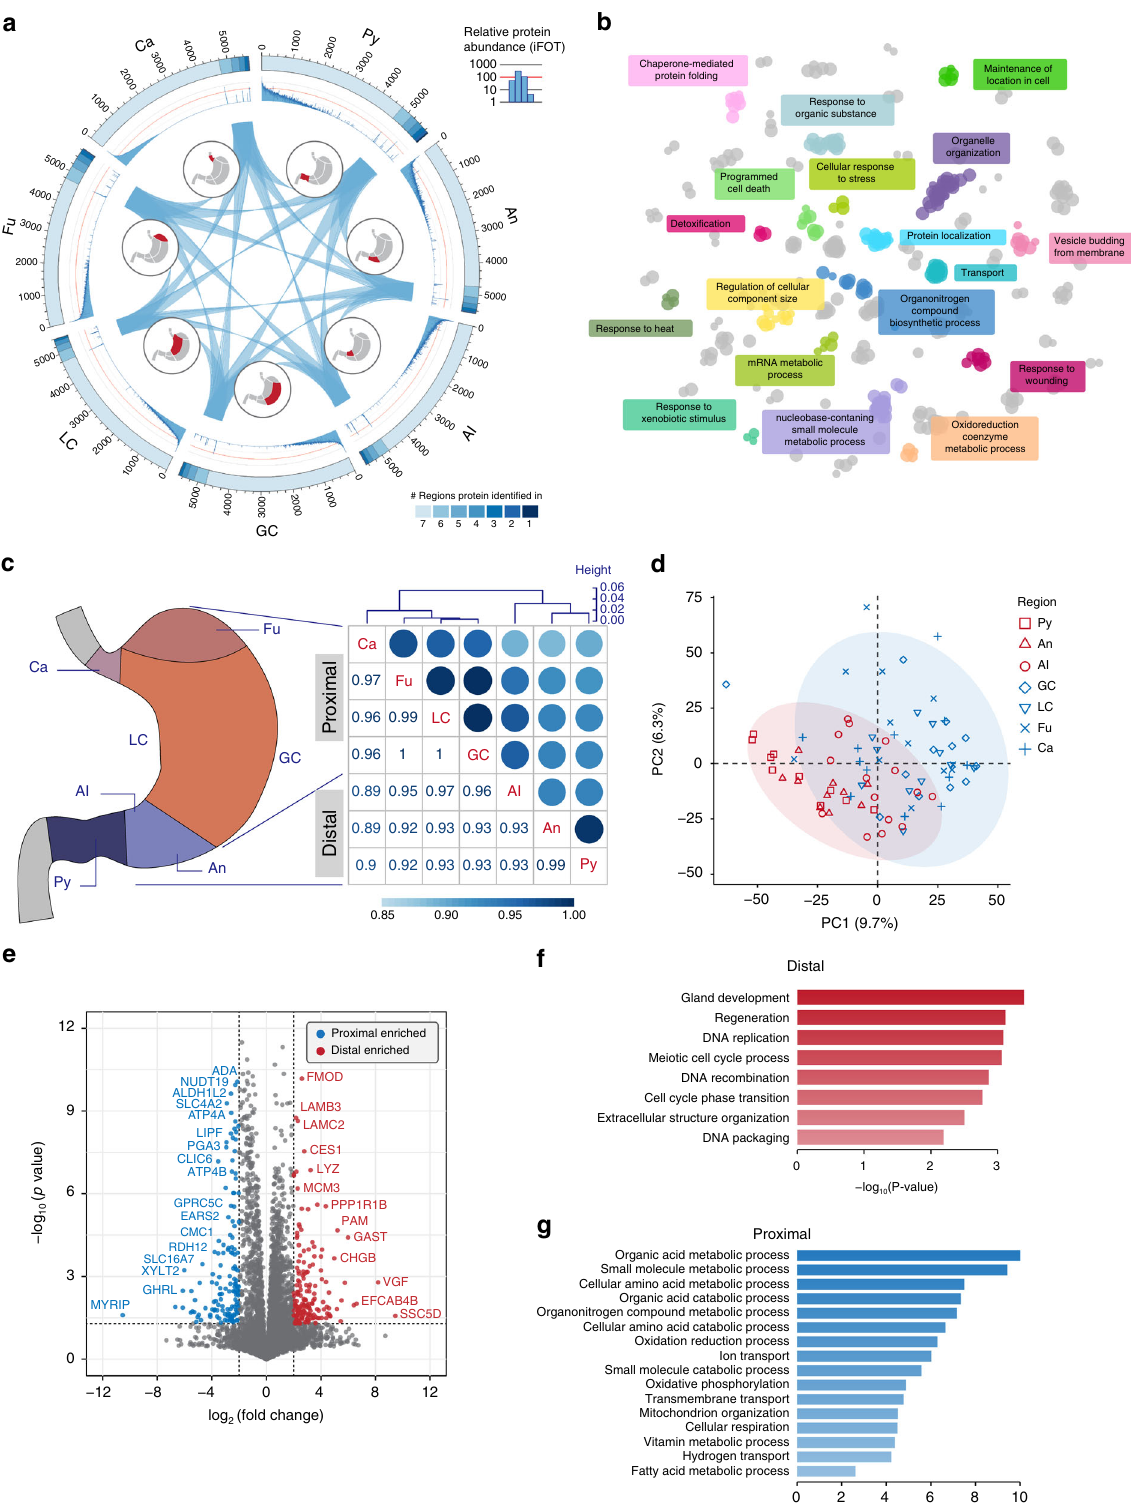
seven regions, which we designate them as the mucosa core proteome (Supplementary Fig. 3a). They are highly expressed (Fig. 2a, blue histogram) and signi fi cantly enriched in biological functions including metabolic process, localization, transport, response to organic substance, among others (Fig. 2b, Supple- mentary Fig. 3b, sheet 1 in Supplementary Data